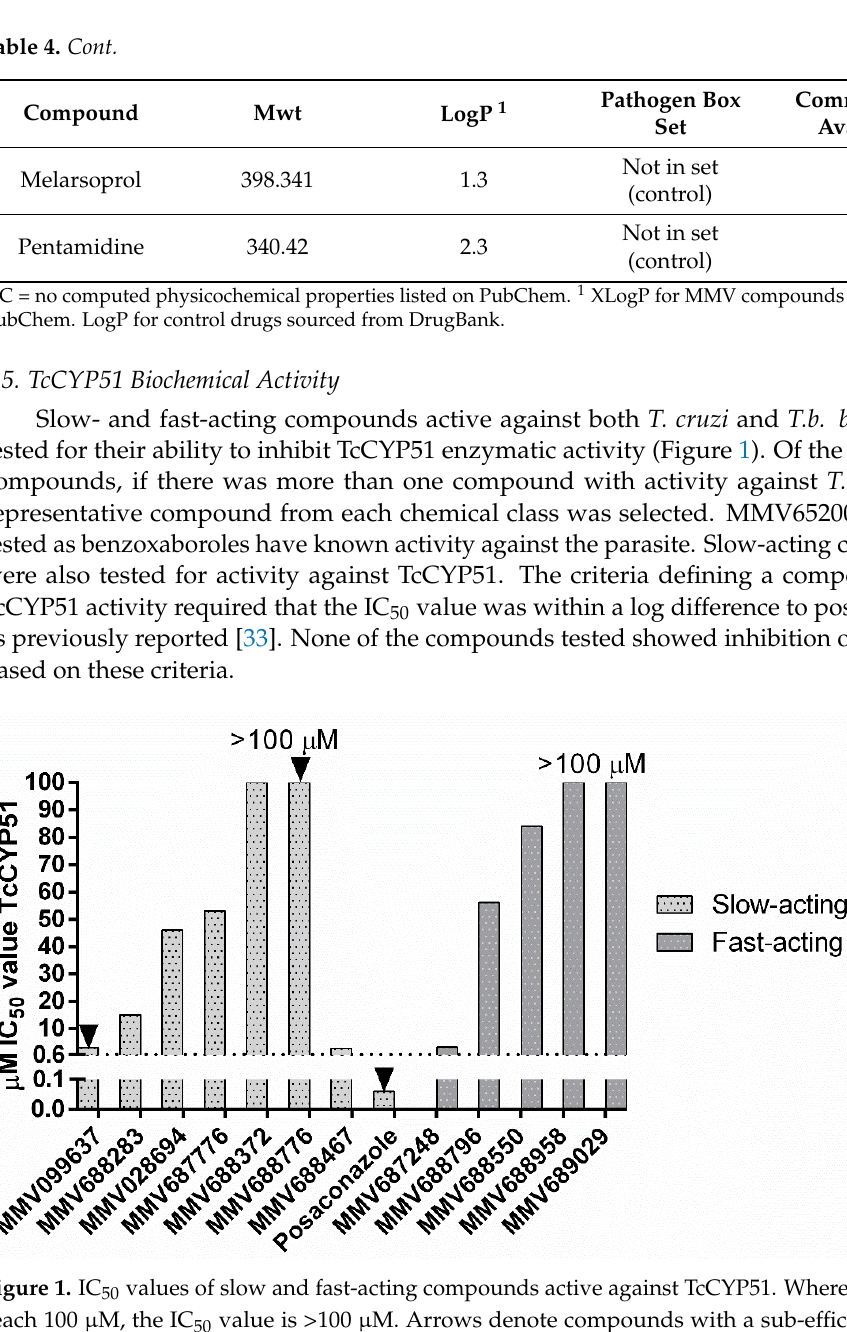
Table 5. Prioritised compounds from the Pathogen Box with activity against both T. cruzi and T. brucei recommended for progression.